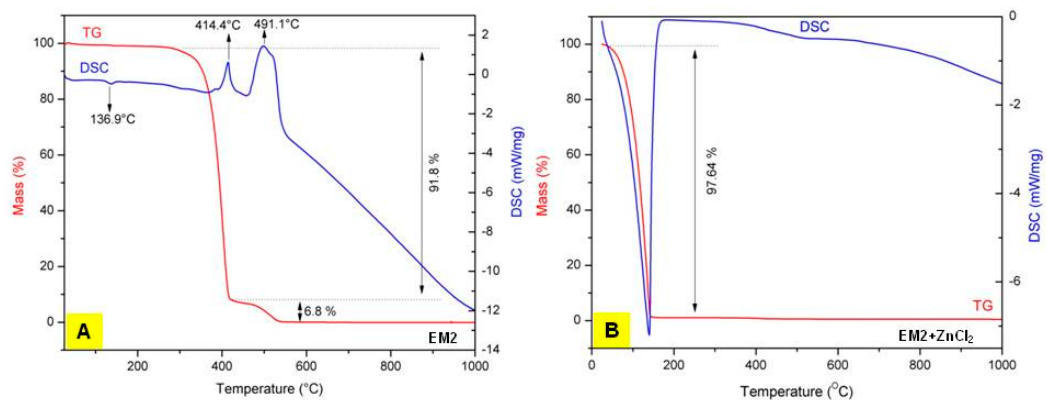
Figure 4. Thermogravimetry-di ff erential scanning calorimetry (TG-DSC) curves of A : EM2 [29] and of the B : EM2 + ZnCl2 mixture.